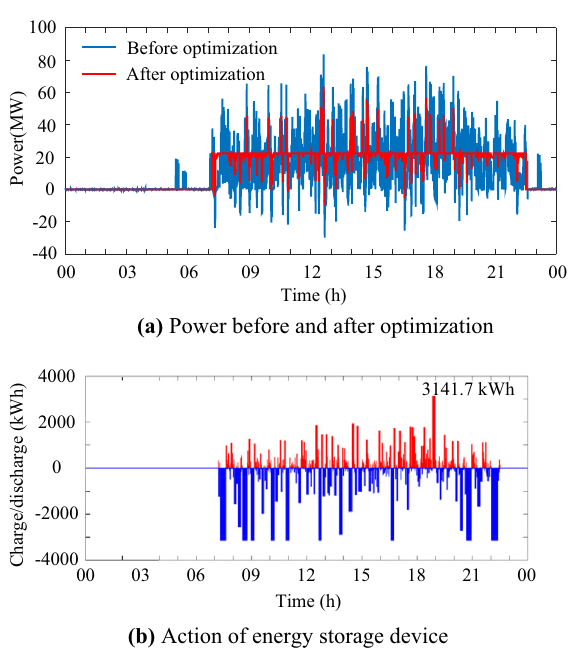
Fig. 15 Power fluctuation optimization at Danyang traction